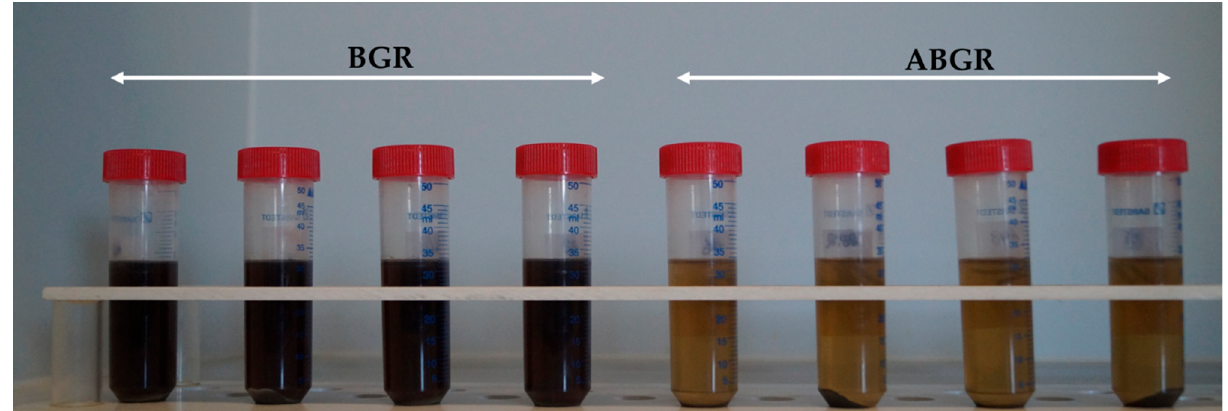
Figure A1. BGR and ABGR after centrifugation before determination of dissolved nutrients.